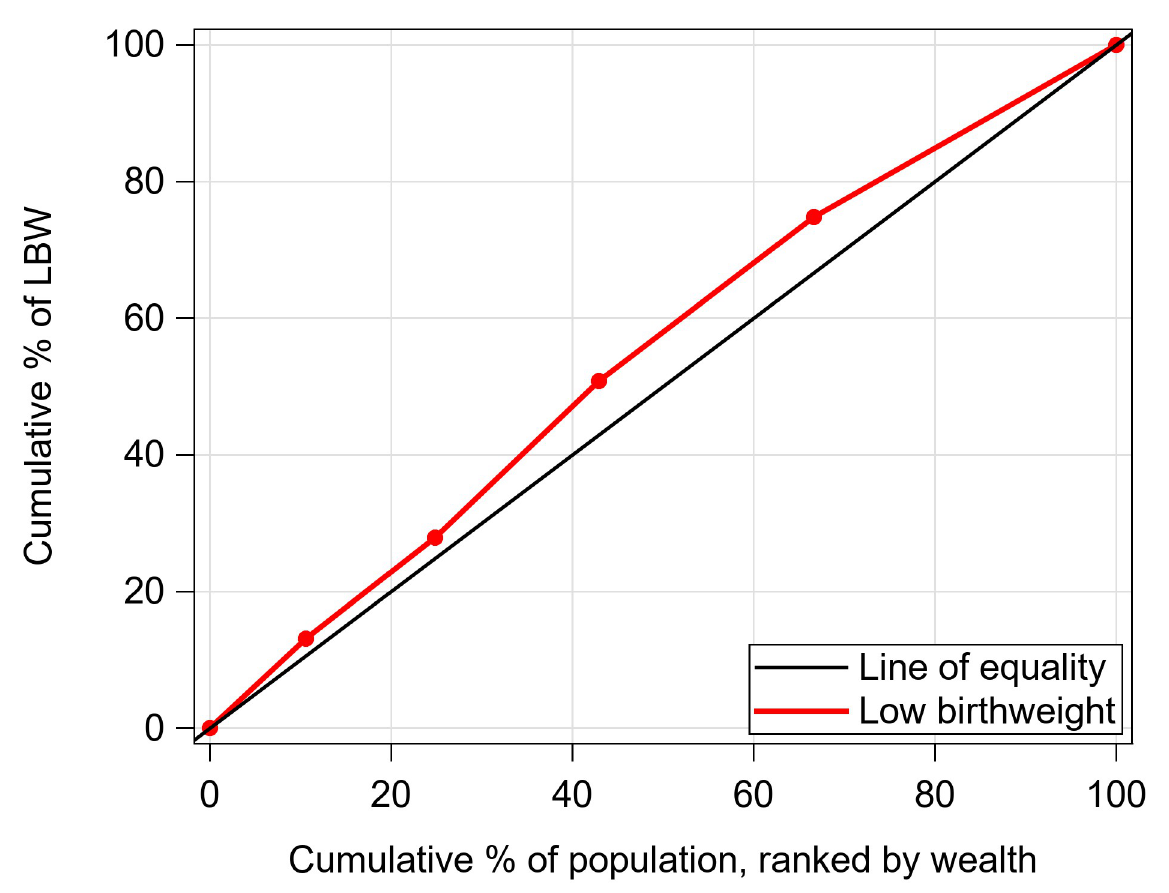
Fig 3. Concentration curve for LBW babies ranked by wealth in Bangladesh.